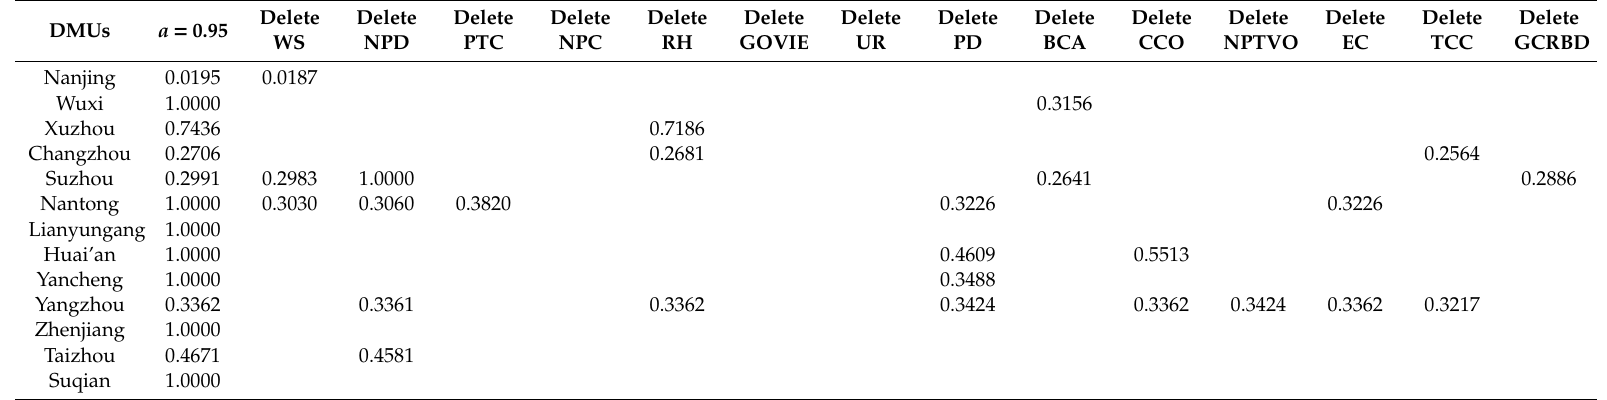
Table A7. The changes of stochastic e ffi ciency value by deleting single input variable in 2016 ( α =